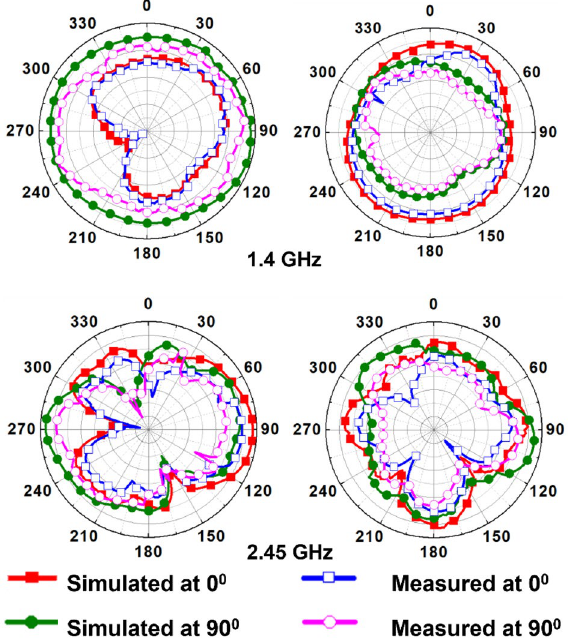
Figure 21. Comparison of simulated and measured radiation patterns of the proposed integrated antenna in pork for: ( a ) E -plane ( ϕ = 90°) ( b ) H -plane ( ϕ = 0°).